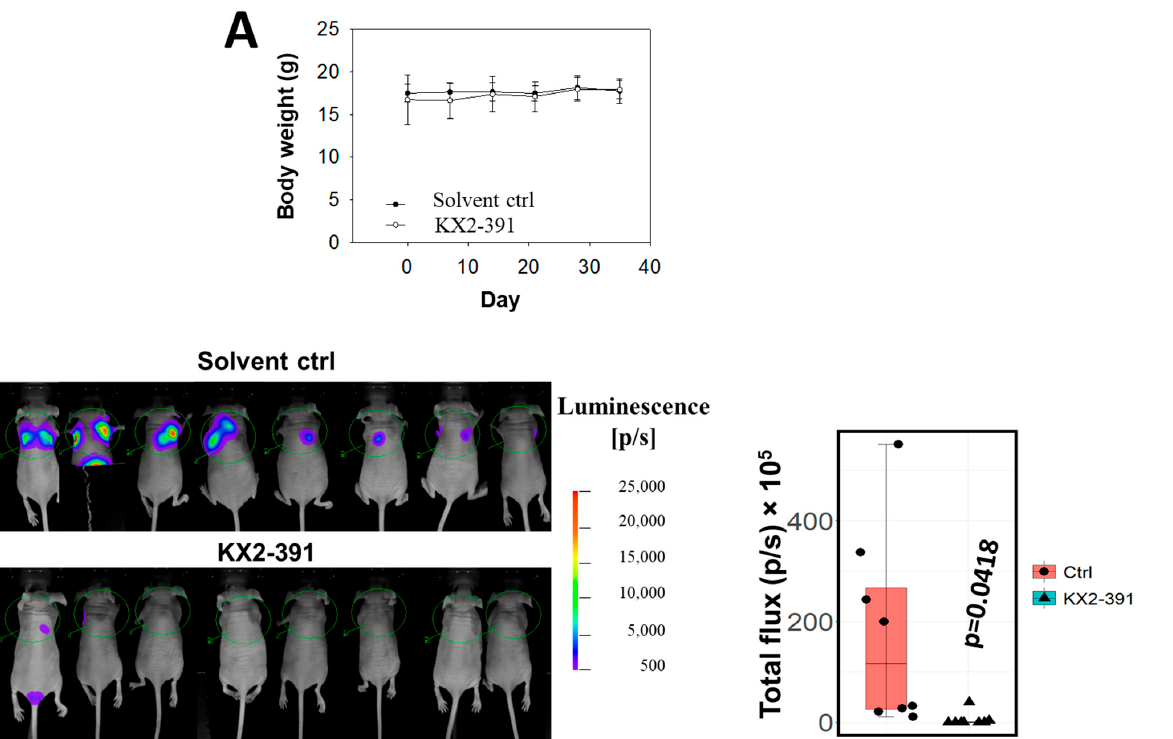
Figure 6. KX2-391 inhibits the lung metastasis of NPC cells. ( A ) The body weight of the mice in the treatment with KX2-391 was analyzed. ( B ) The in fi ltrated HONE1 cells in the lungs were re fl ected by the bioluminescence signals in the nude mice ( n = 8). The luminescence readings from all the mice were presented as a box plot, and each data point was shown. ( C ) Representative H&E staining of the mouse lungs (Scale bar, 2 mm). 4. Discussion Metastasis remains one of the biggest challenges in the management of NPC, and hyperactivity of SRC has been found to be associated with poor prognosis and to induce